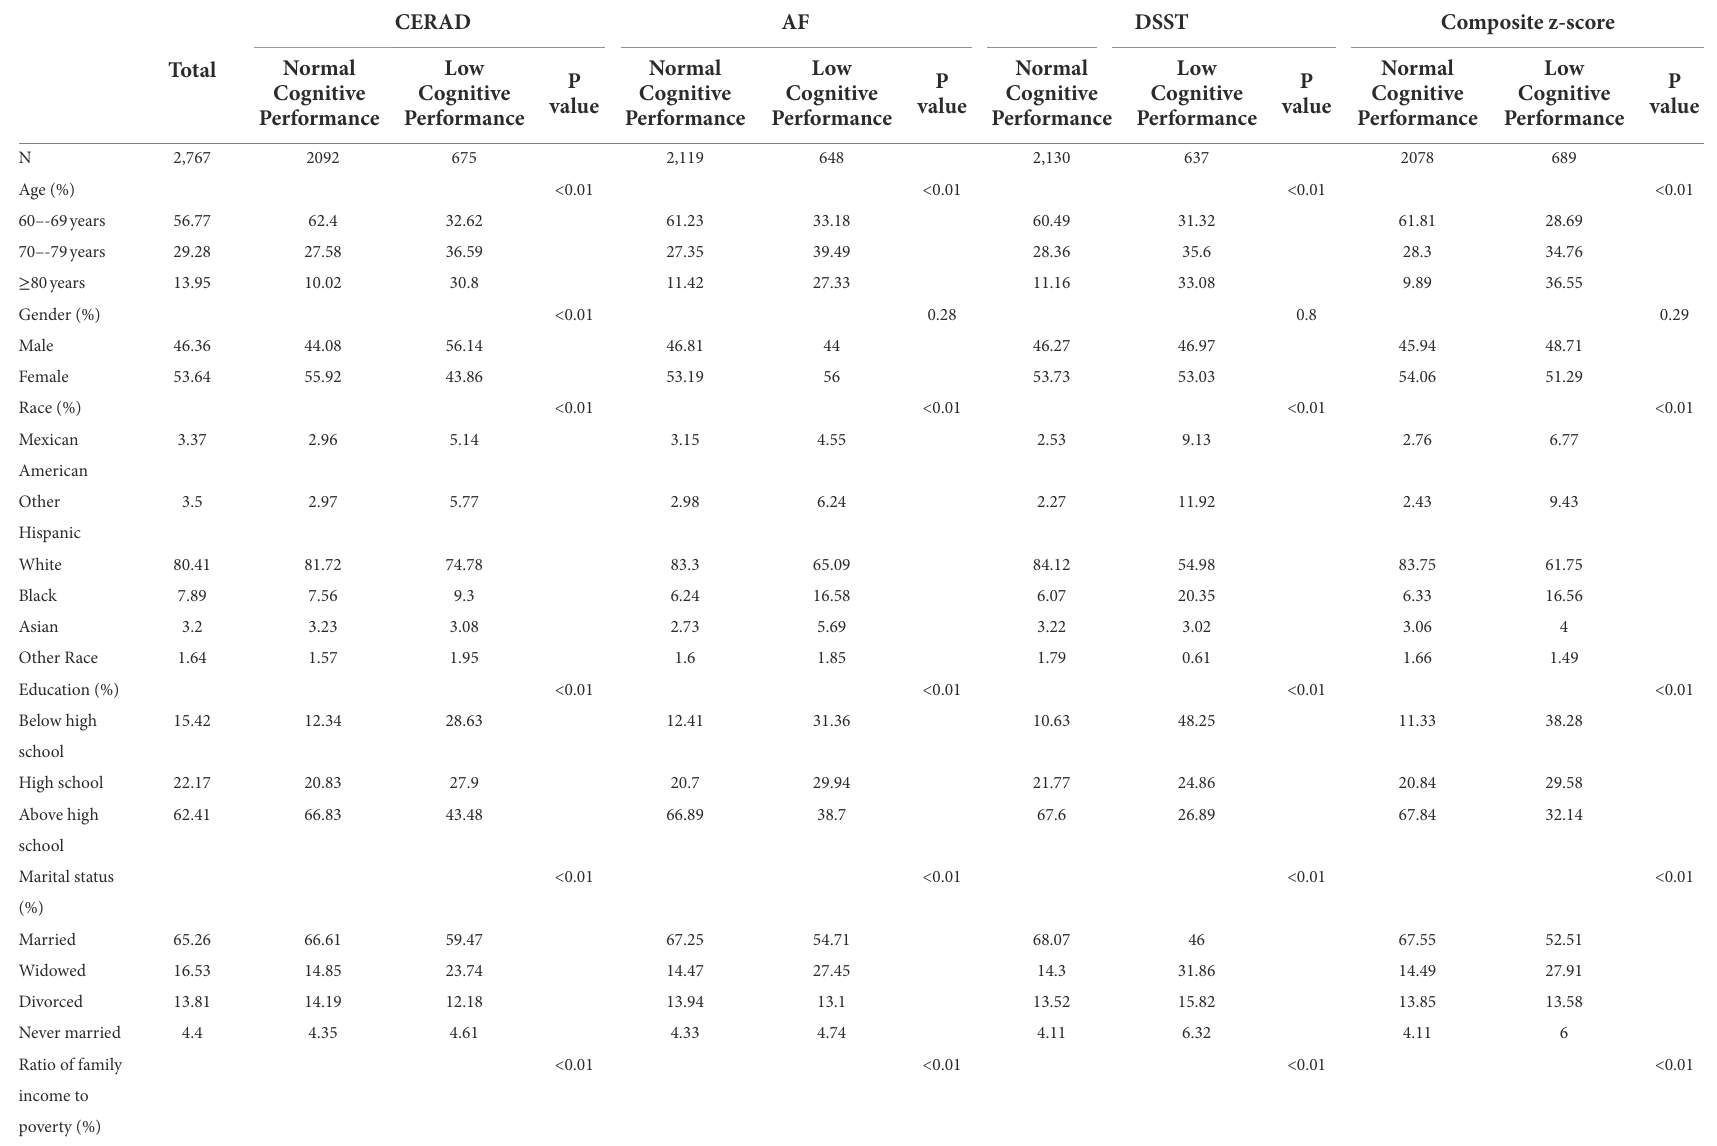
TABLE 1 Weighted study population characteristics based on cognitive grouping. CERAD AF DSST Composite z-score Normal Low Normal Total P Cognitive Cognitive value Performance Performance